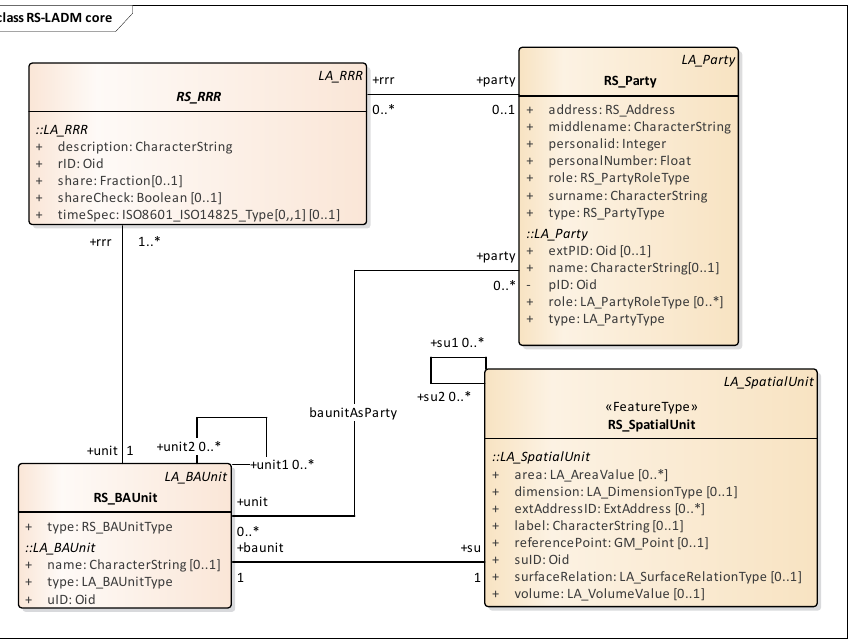
Figure 7. LADM core clasess.